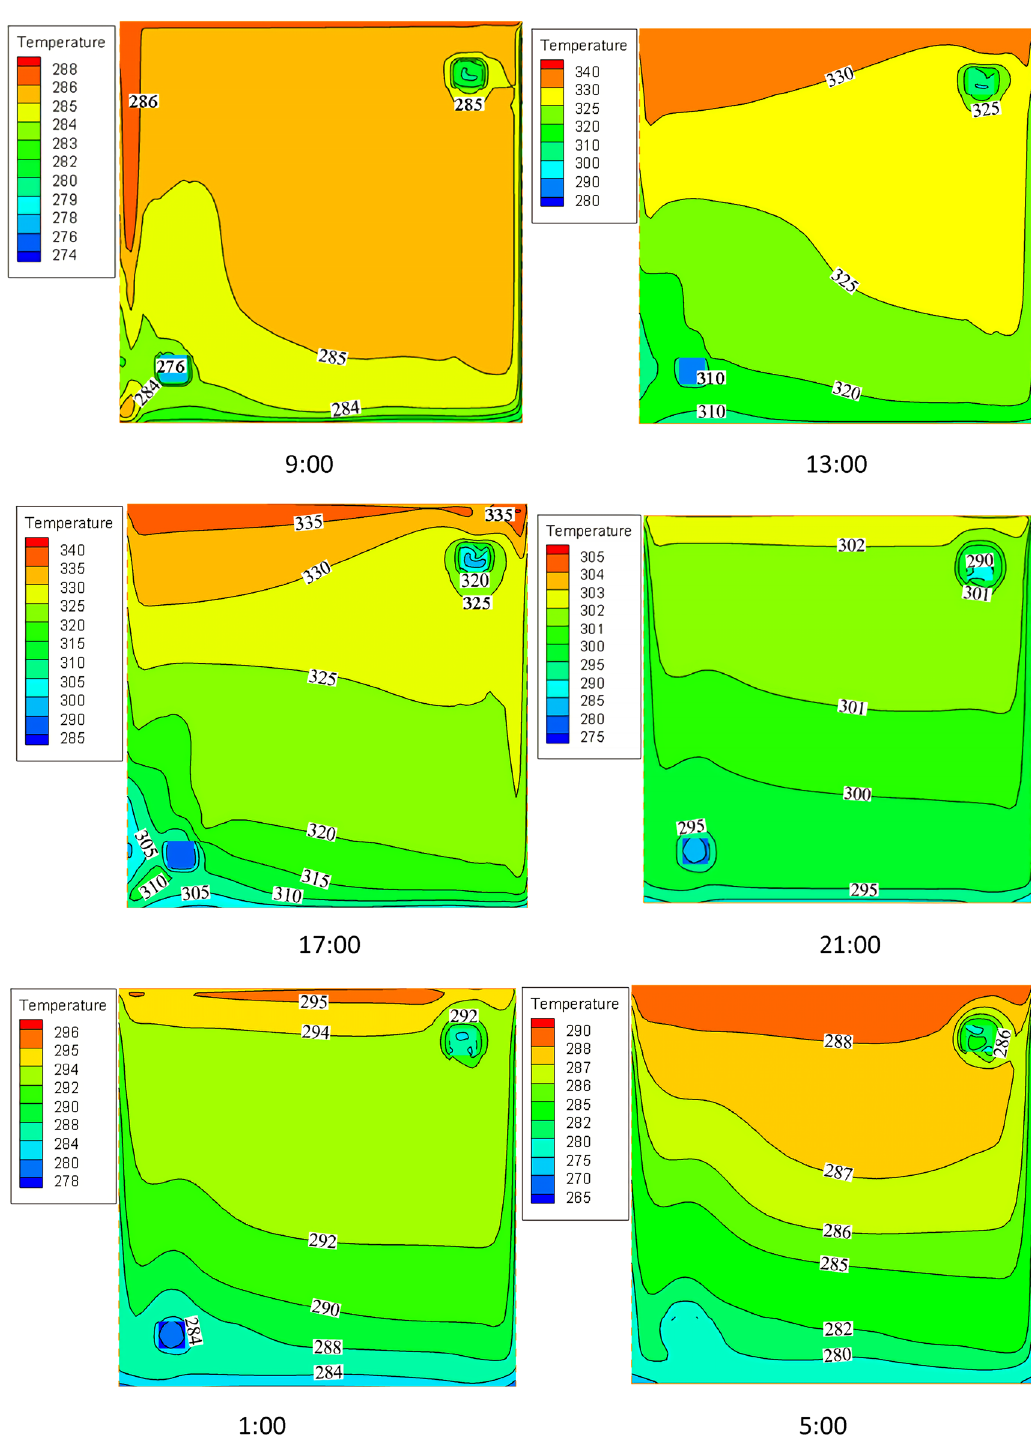
Figure 8. The temperature field of the outer surface of the porous wall at different